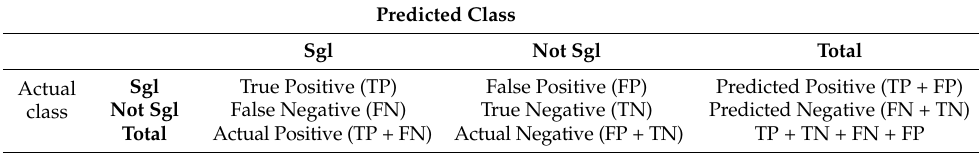
Table 1. Confusion matrix for accuracy assessment.